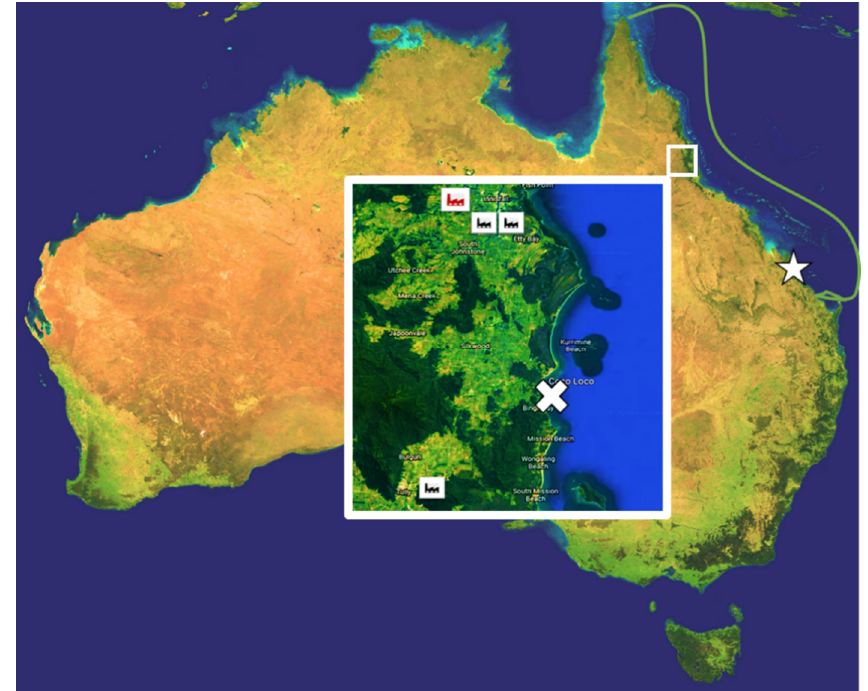
Figure 1. Location of the atmospheric deposition sampling station. The white cross on the insert map and Port Curtis, where concentration of trace metals in river water were determined by Angel et al. [71] (white star on the main map) for assessment of atmospheric deposition fluxes in part 3.3. Black and red symbols on the insert indicate sugar cane mill (black) and iron smelter and steel manufacturing (red) locations (National Pollution Inventory). The green line indicates the Great Barrier Reef.